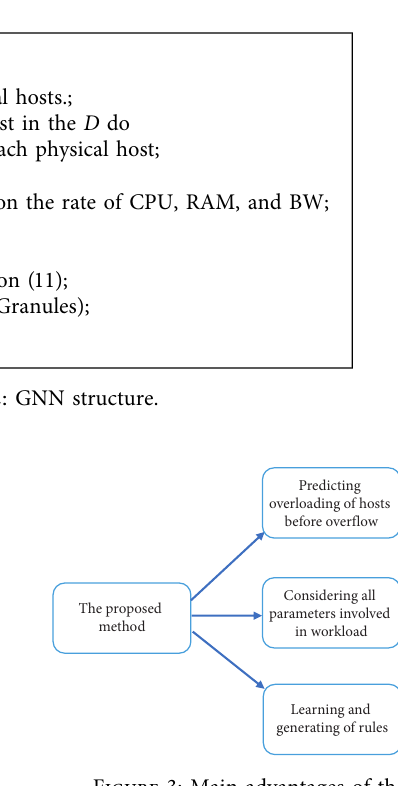
Figure 3: Main advantages of the proposed